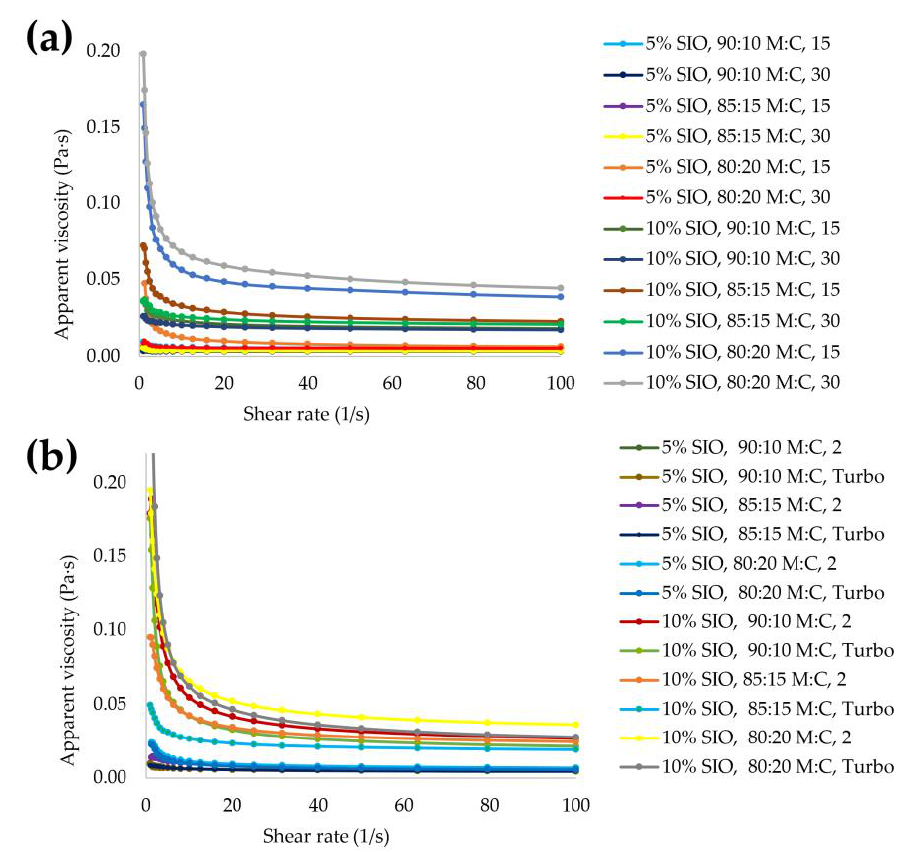
Figure 1. ( a ) Flow behavior of sacha inchi seed oil emulsions made with conventional homogenization and ( b ) ultrasound probe homogenization.